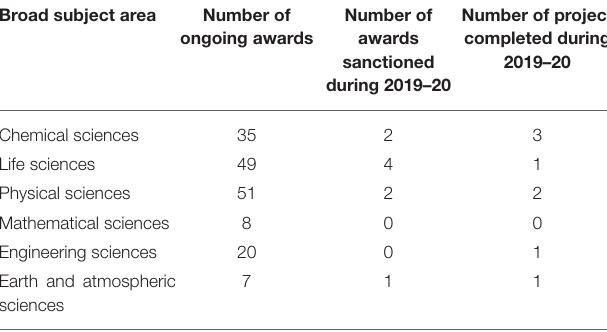
TABLE 1 | Summary of Ramanujan fellowship